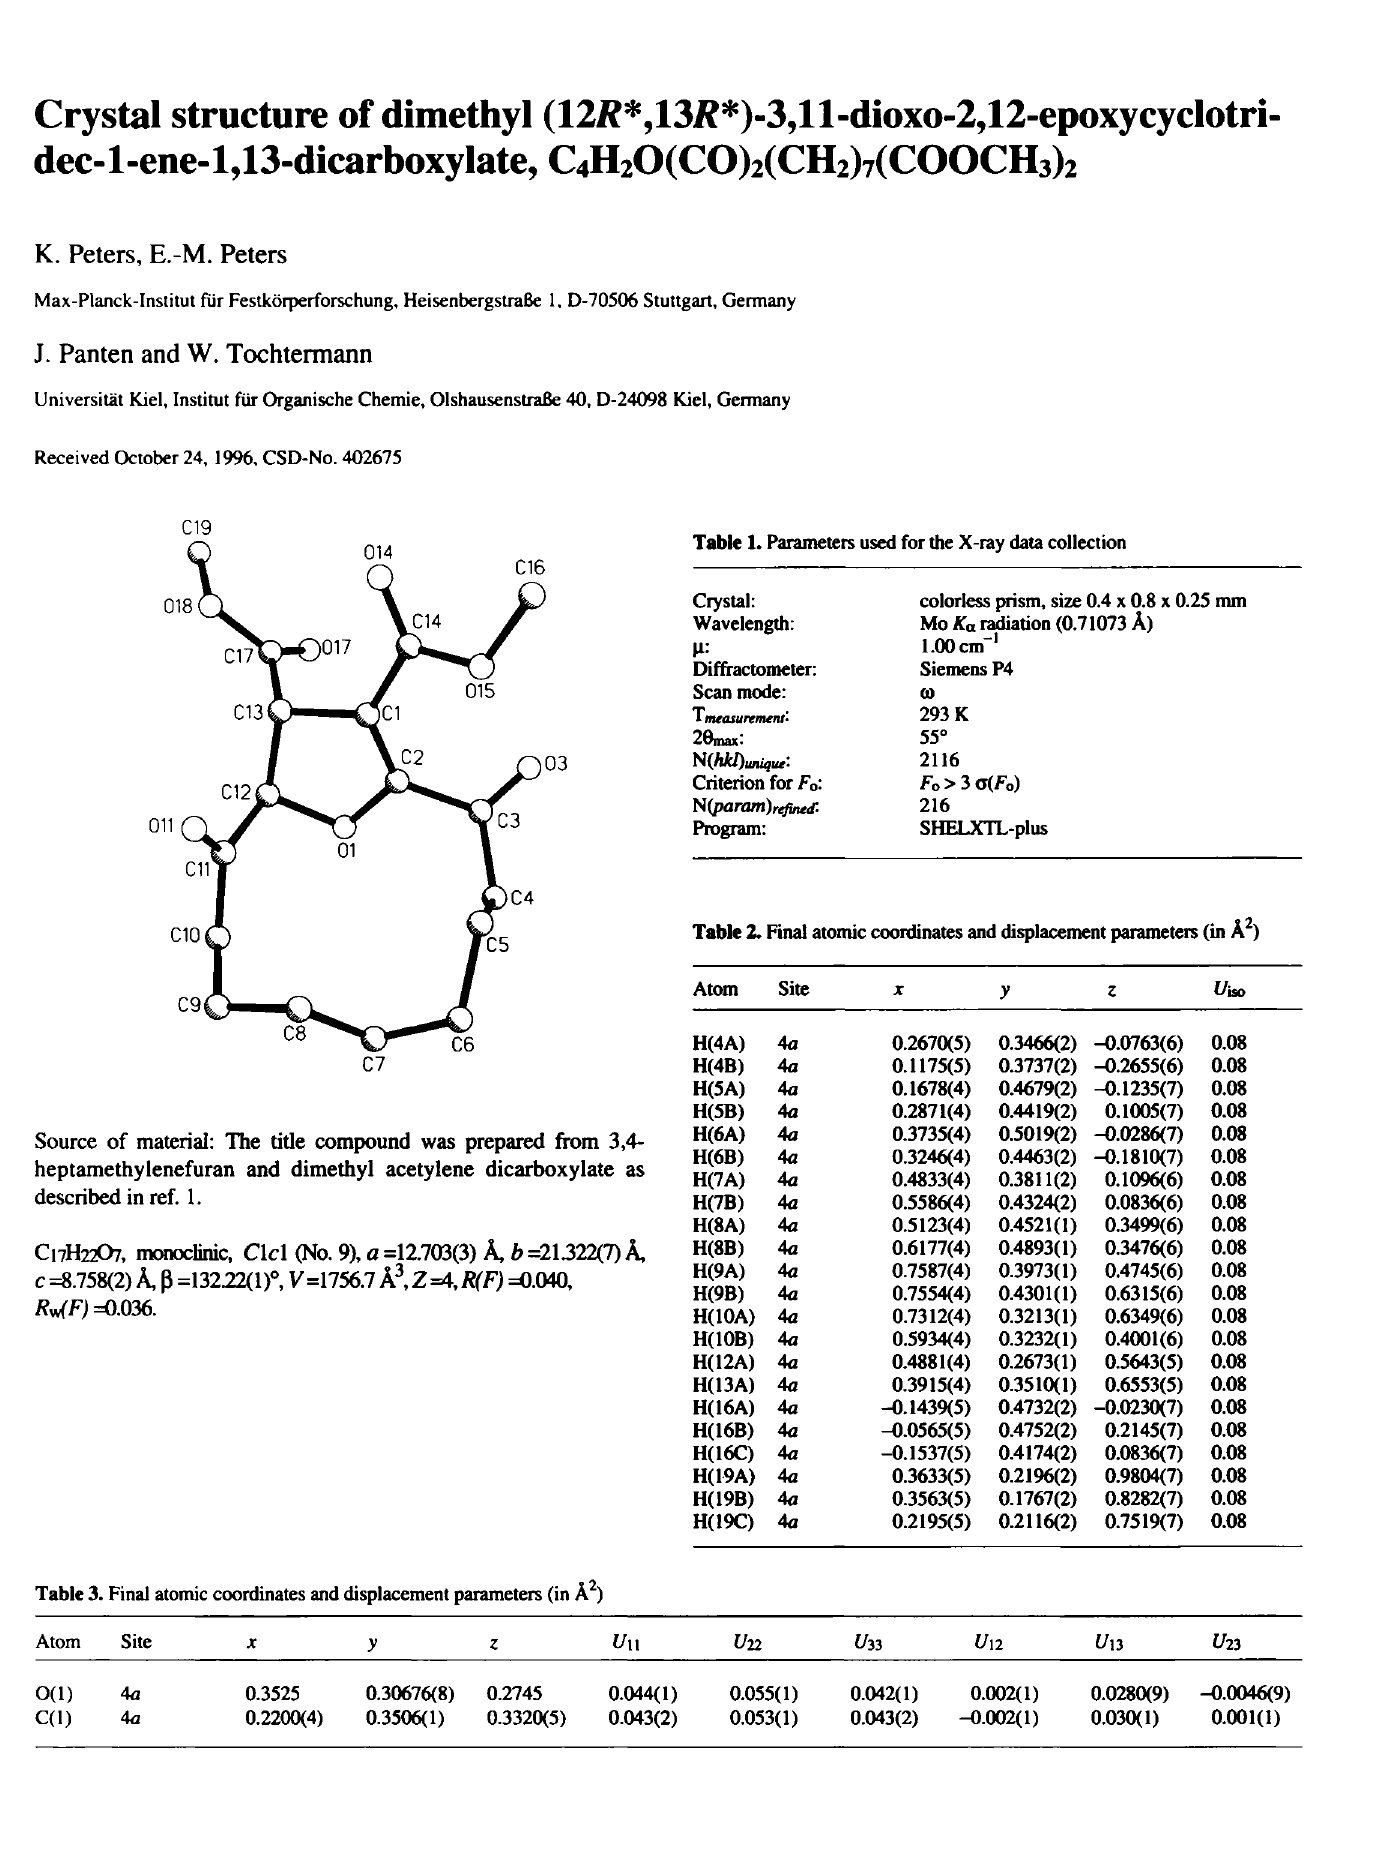
Table 3. Final atomic coordinates and displacement parameters (in Ä 2 ) Atom